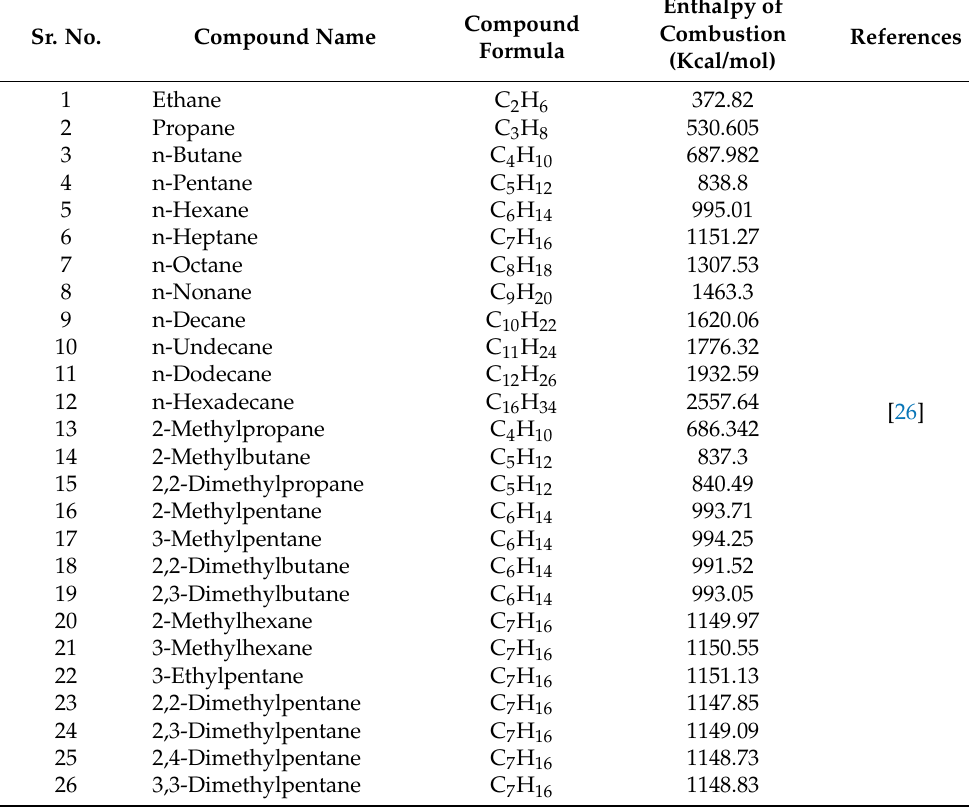
Table 2. Enthalpy of combustion of different compounds from the literature.